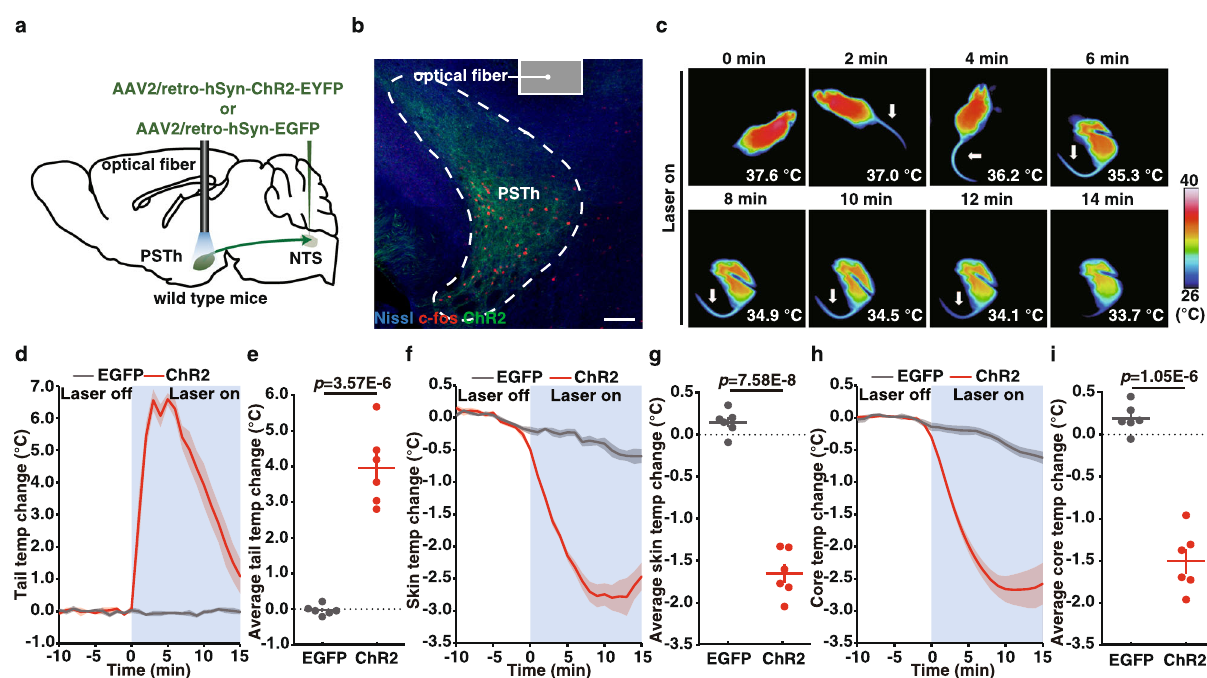
Fig. 4 Activation of NTS-projecting PSTh neurons evokes hypothermia and tail temperature increase. a Schematic of optogenetic activation of the PSTh-NTS pathway in wild-type mice. b Representative image showing c-fos expression in ChR2-labeled PSTh neurons after photoactivation ( n = 6). c Time-lapsed thermal images of ChR2-expressing mice during photoactivation of the NTS-projecting PSTh neurons. Tail ( d ), skin ( f ), and core ( h ) temperature curves of EGFP-expressing ( n = 6) and ChR2-expressing mice ( n = 6) before and during photoactivation of the NTS-projecting PSTh neurons. Average tail ( e ), skin ( g ), and core ( i ) temperature changes of EGFP-expressing ( n = 6) and ChR2-expressing mice ( n = 6) during photoactivation of NTS- projecting PSTh neurons. d – i Data are mean ± SEM; two-side Student ’ s t test. Scale bar, 100 µ